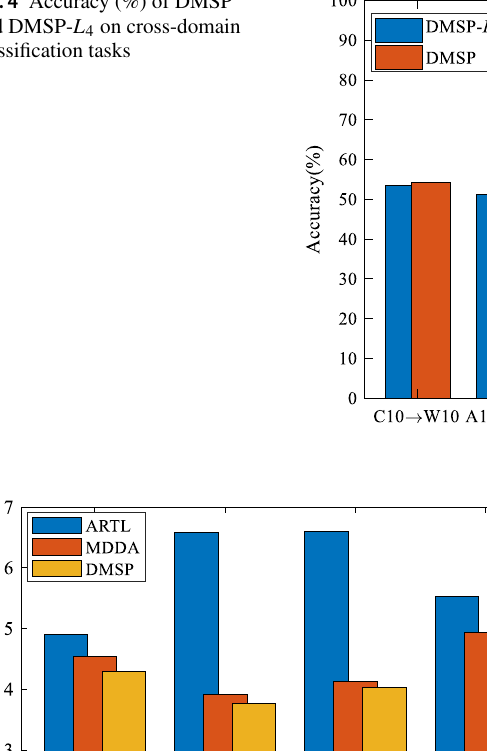
Fig. 4 Accuracy (%) of DMSP and DMSP- L 4 on cross-domain